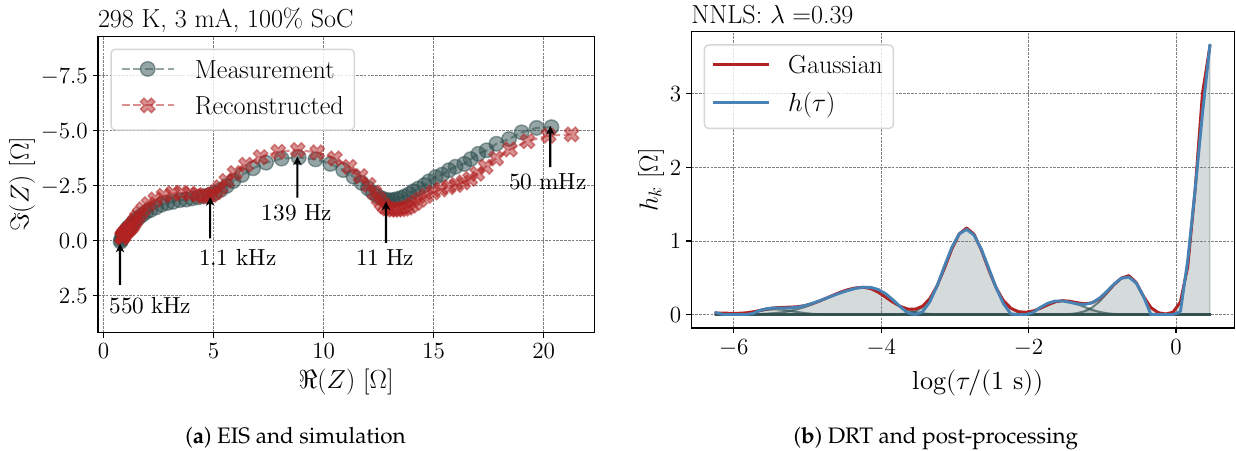
Figure 3. Problem of a not converging EIS measurement at low frequencies. The main peak in the DRT ( b ) is attributable to the diffusion part, which leads to higher regularization parameters and thus larger deviations ( a ) in the